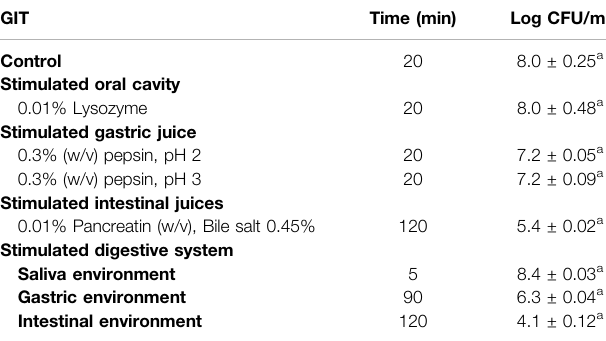
a Indicates standard deviation of three replicates. The values with the same superscript are not signi fi cantly different ( p ≥ 0.05).